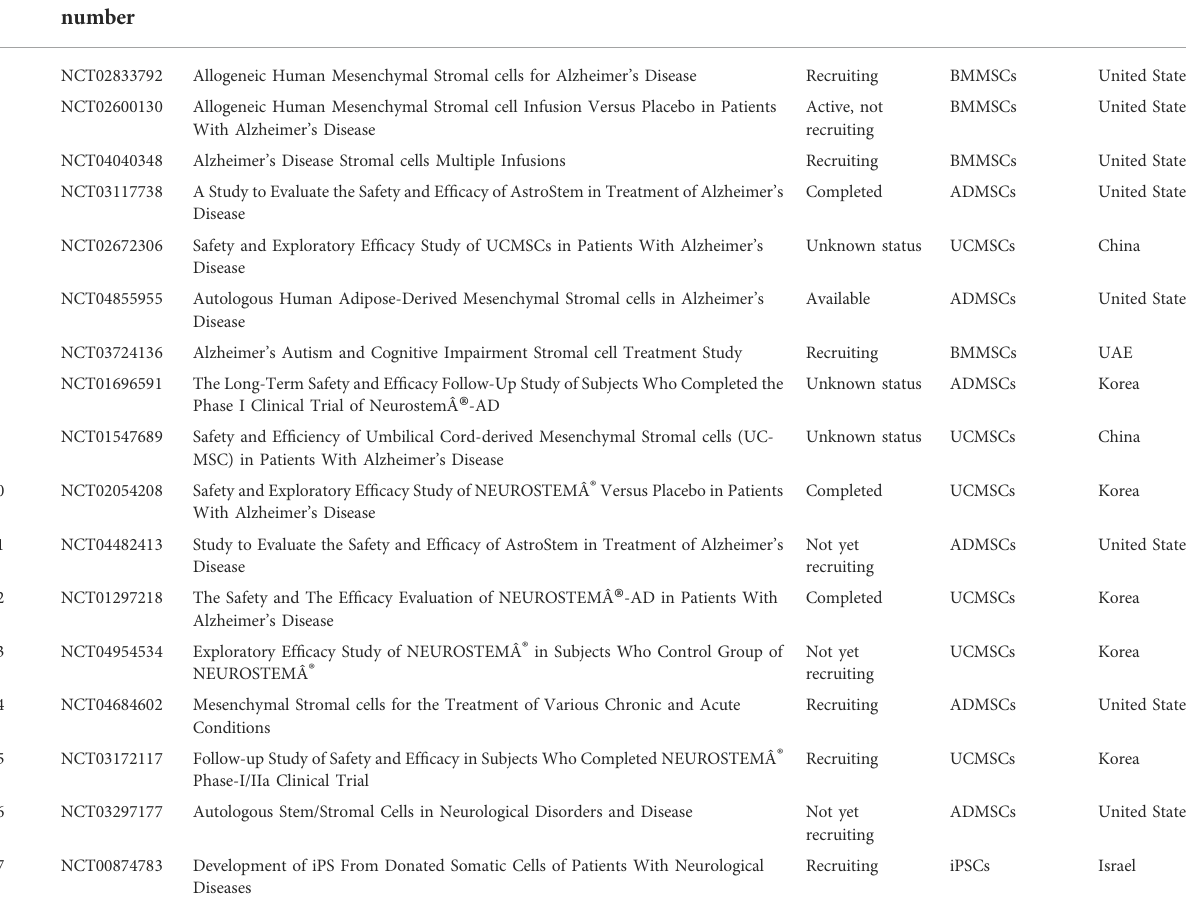
TABLE 2 Clinical trials of Alzheimer ’ s disease incorporating stromal